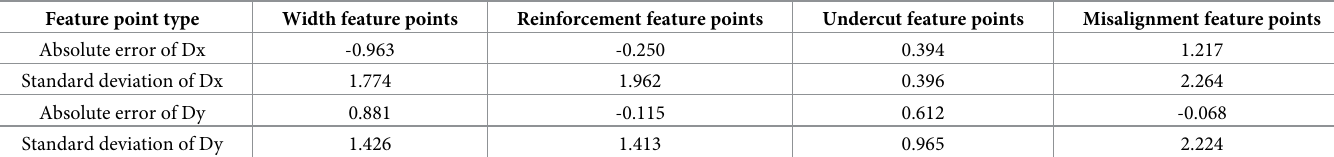
Table 6. Feature point extraction error